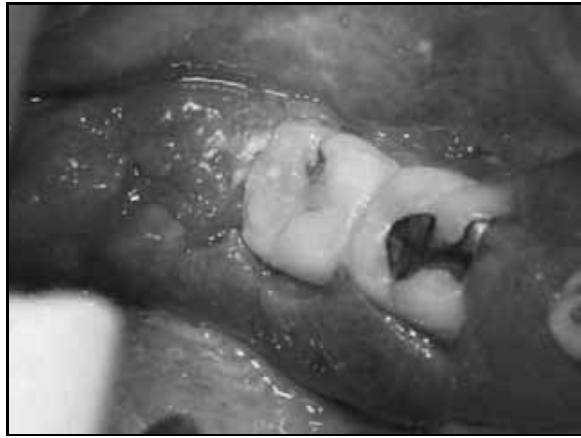
Figure 1 – Exophytic lesion with lobulated area located in retromolar region of the mandible